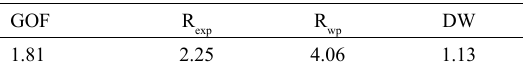
Table 2: R-values of Rietveld refinement displayed in Figure 3. GOF: Goodness of fit; R : expected weighted profile R-factor; exp R : weighted profile R-factor; DW: weighted wp